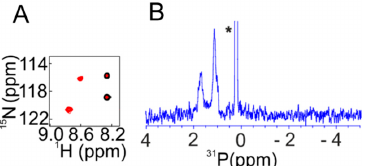
Figure 5. NMR signature of serine phosphorylation using a short peptide (A57-F86 selectively labeled with 15 N-Ser66 and 15 N-Ser76) of p19 INK4d modified by HeLa cell lysate. (A) Overlaid 2D 1 H– 15 N HSQC spectra of untreated (black) and treated (red) peptide showing the typical low-field shift of the serine amide proton upon side-chain phosphorylation. (B) 31 P NMR spectra of the phosphorylated A57-F86 peptide. The asterisk in (B) shows the signal of the phosphate buffer.